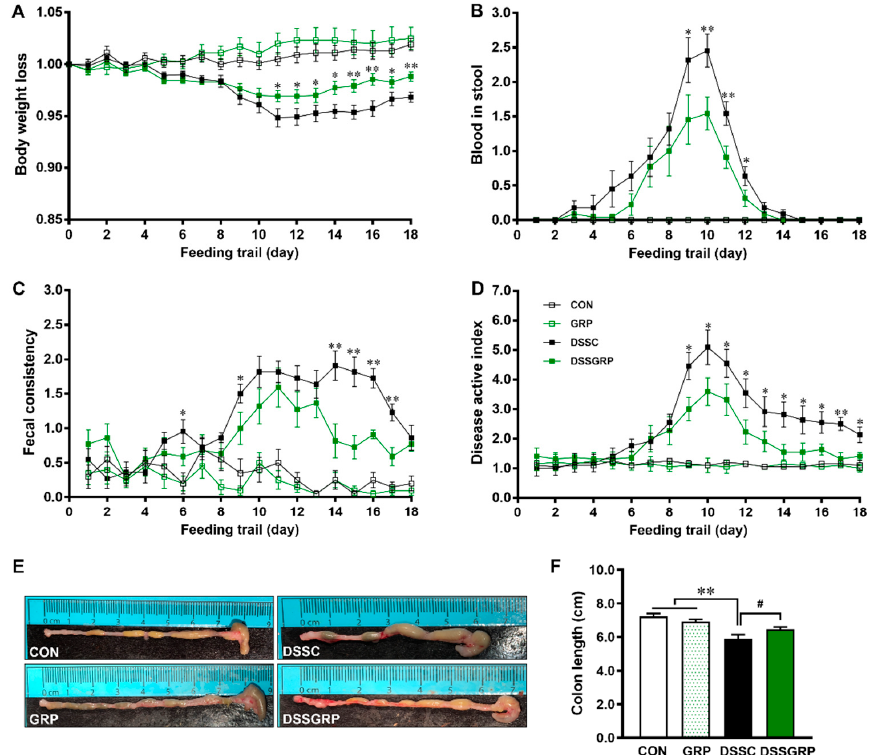
Figure 1. GRP supplementation suppresses disease symptoms in DSS-induced colitis mice. ( A ) Body weight loss. ( B ) Blood in stool. ( C ) Fecal consistency. ( D ) Disease activity index. ( E ) The representative images of the dissected colon. ( F ) Colon length. CON: Control, GRP: Sulforaphane glucosinolate, DSSC: DSS-treated control mice, DSSGRP: DSS-treated mice with GRP supplementation. Mean ± SEM, n = 10. # p < 0.10, * p ≤ 0.05, ** p ≤ 0.01.